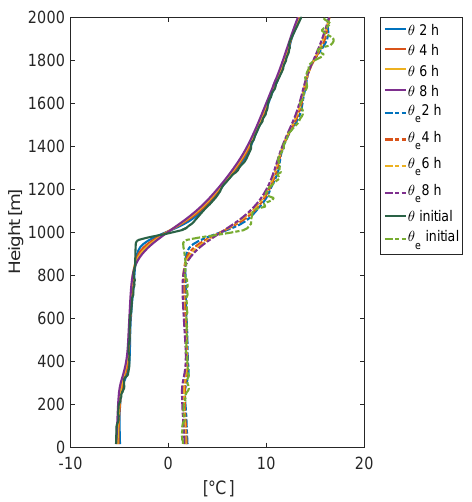
Figure 13. θ (left) and θ e (right) profiles of the initial condi- tions (dark green and green) and domain-averaged profiles after 2h (blue), 4h (orange), 6h (yellow), and 8h (purple) after the start of the SensCDNC simulation with a decreased CDNC of 2cm − 3